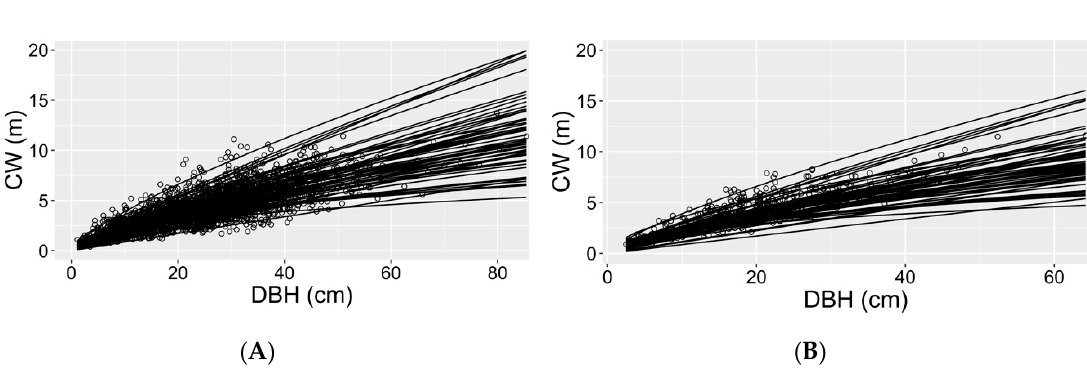
Figure 5. Localized curves of the generalized mixed model (GMM2) based on four randomly selected trees overlaid on the fitting data ( A ) and on validation data ( B ).